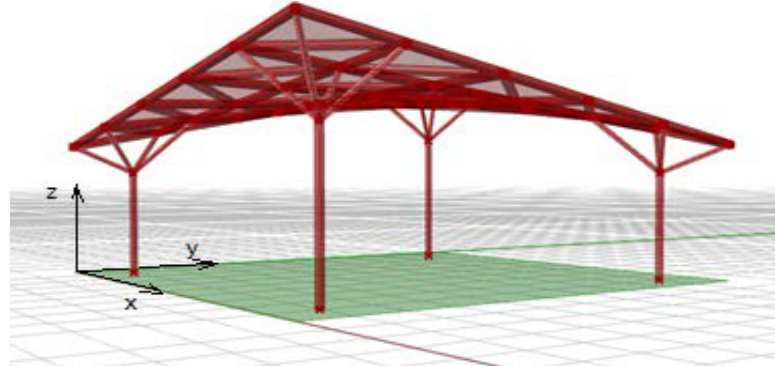
Figure 2. The view of the considered structure.